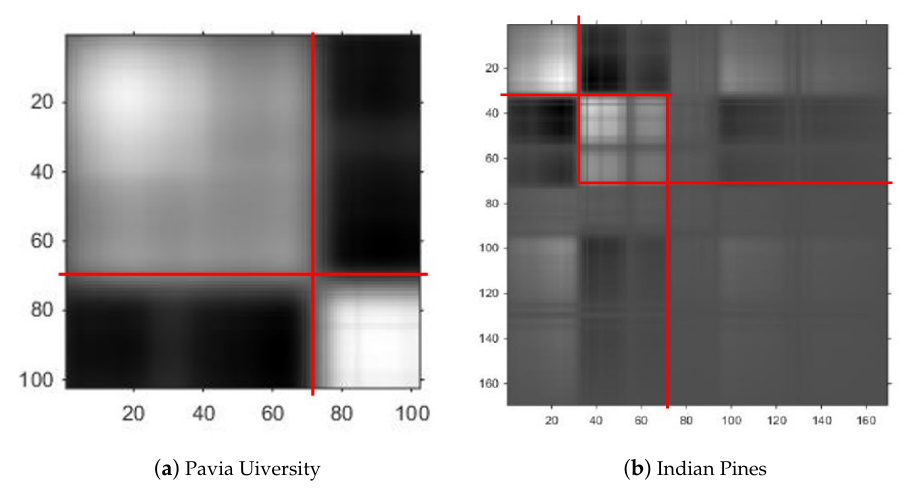
Figure 3. Spectral correlation matrices for Pavia University dataset and Indian Pines dataset. Darker indicates less correlation, while lighter represents more